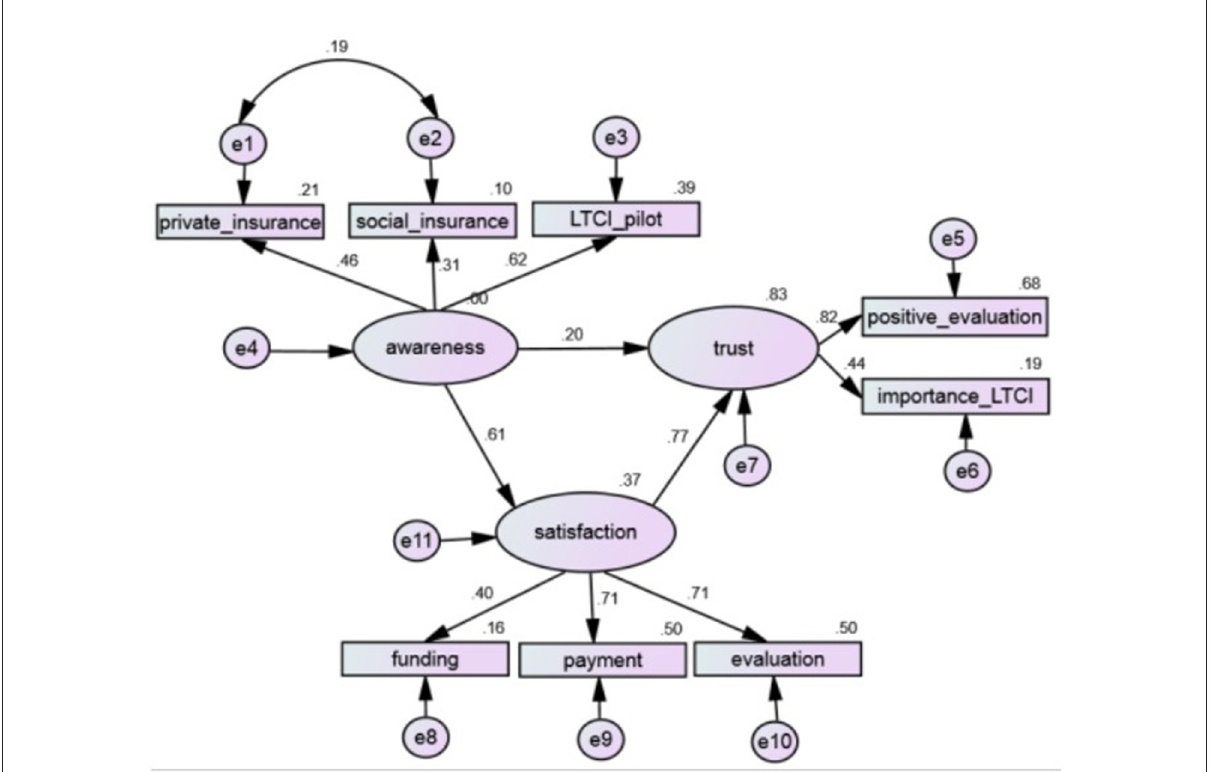
FIGURE1 Structural equation modeling of satisfaction as a mediator of trust.